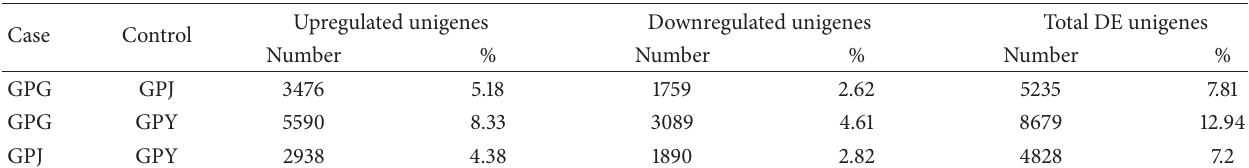
Table 4: Overview of the upregulated and downregulated unigenes.